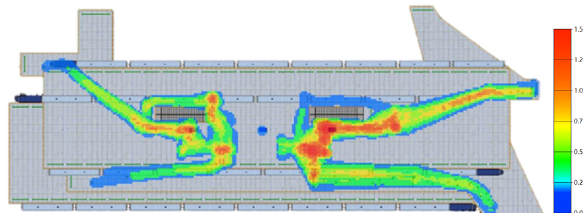
Figure 10. Pedestrian distribution density at 60 s.